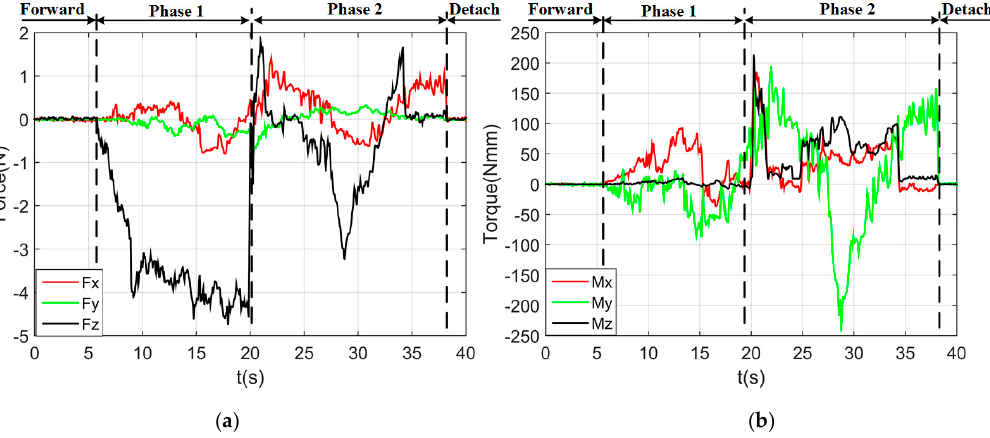
Figure 15. Square pieces: interacting forces and torques toward single-arm operation (Phase 1: outside adjustment phase; Phase 2: inside adjustment phase). ( a ) Interaction forces; ( b ) interaction torques.